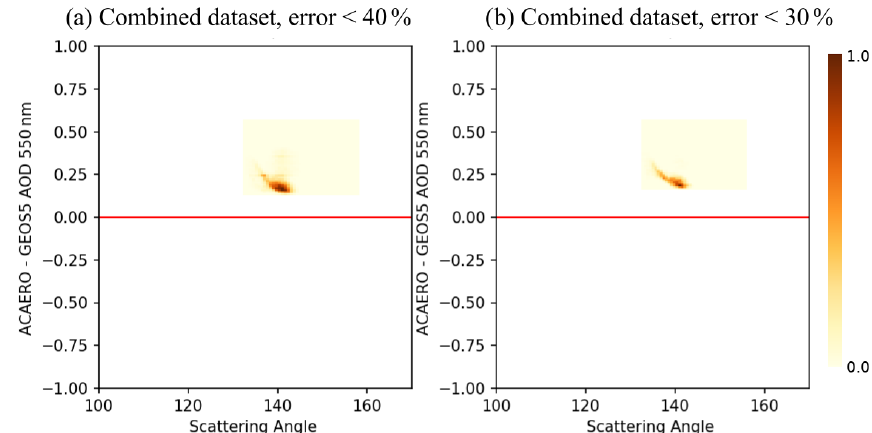
Figure 6. MOD06ACAERO retrieval results from the combined dataset of Fig. 3b, where aerosols had been removed. The results are displayed as difference from GEOS-5 AOD, which in this case was zero, as a function of scattering angle as a normalized density plot. All retrievals where MOD06ACAERO result was also zero had been removed for clarity. All non-zero MOD06ACAERO retrievals appear to be concentrated in a narrow angle range between 135 and 145 ◦ which corresponds to the cloud bow. Panel (a) shows MOD06ACAERO retrievals with uncertainty of less than 40%, and panel (b) shows the same with uncertainty less than 30%.